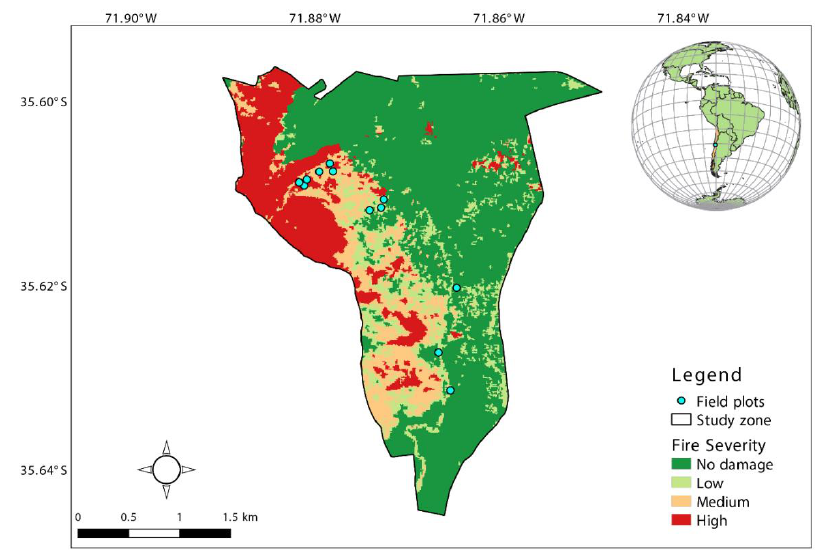
Figure 1. Villavicencio study site, commune of Villa Alegre Region del Maule, Chile.